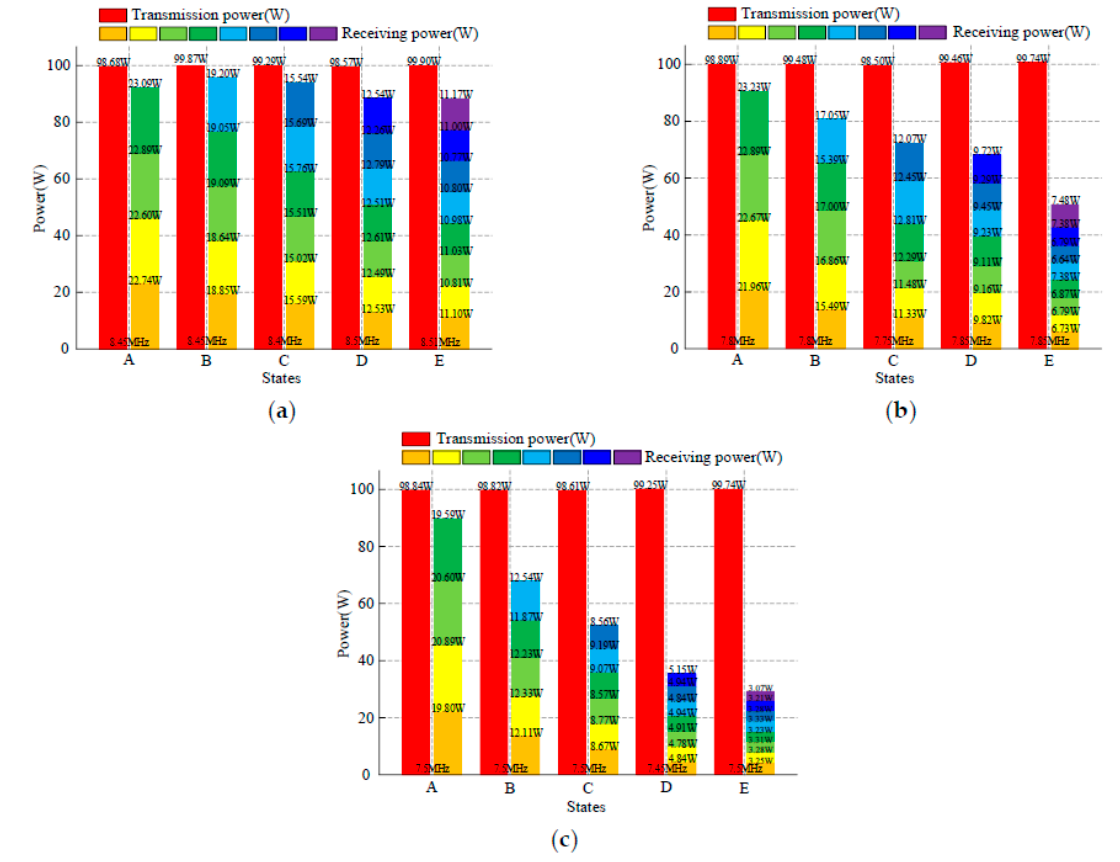
Figure 9. Specific values of transmitting and receiving power of emanant systems, transmission distances are ( a ) 2 m, ( b ) 5 m and ( c ) 10 m.